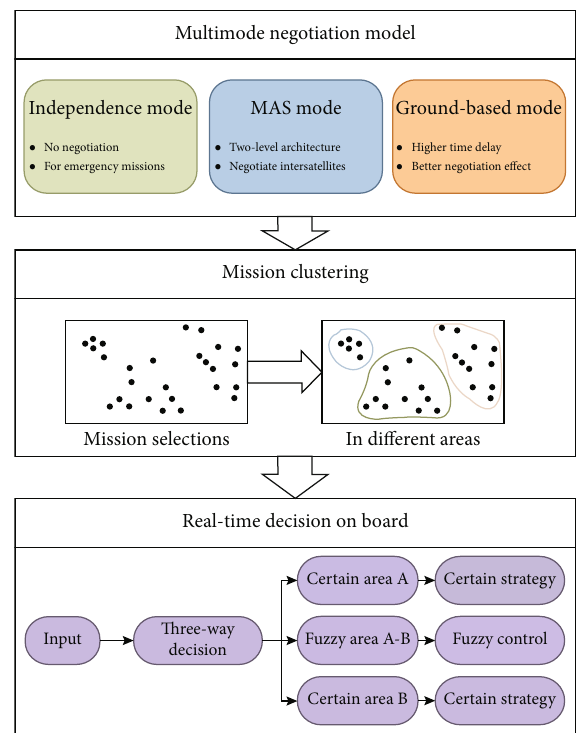
Figure 1: The fl owchart of the multimode method.